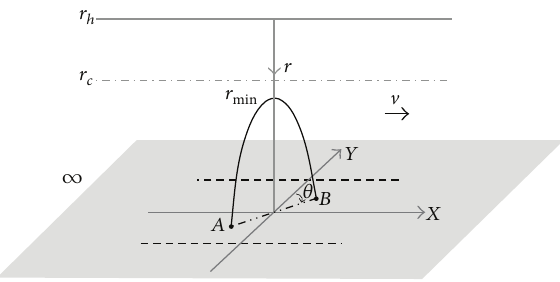
Figure 1: A rotating ∩ -shape string dual to a 𝑞𝑞 pair which can be interpreted as a